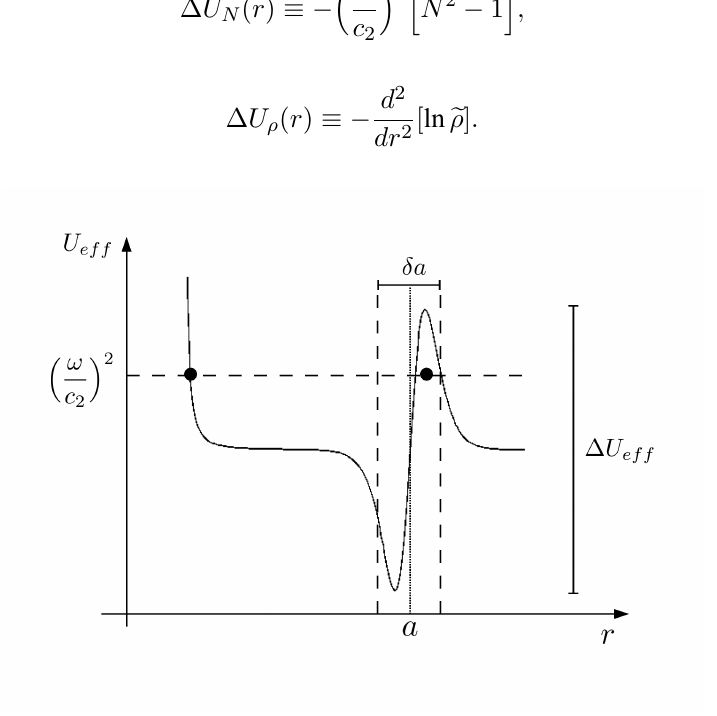
Figure 3 - Sketches the behavior of the effective potential U eff as a function of the radial coordinate r . The incident sound wave is related to the incident particle of “energy” ( ω / c 2 ) 2 . The “potential barrier” ∆ U eff (see Eq. 25) is also